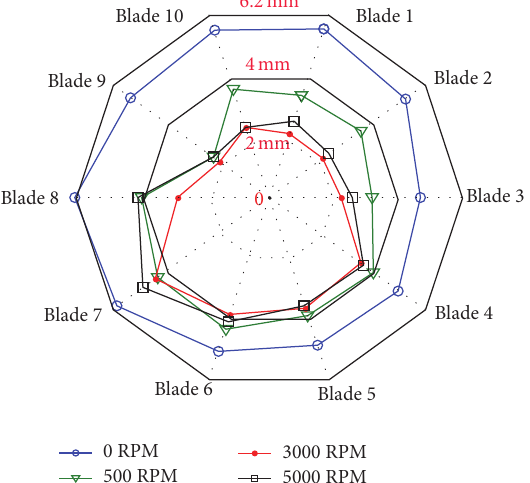
Figure 15: Tip clearance measured at different rotor working speed.